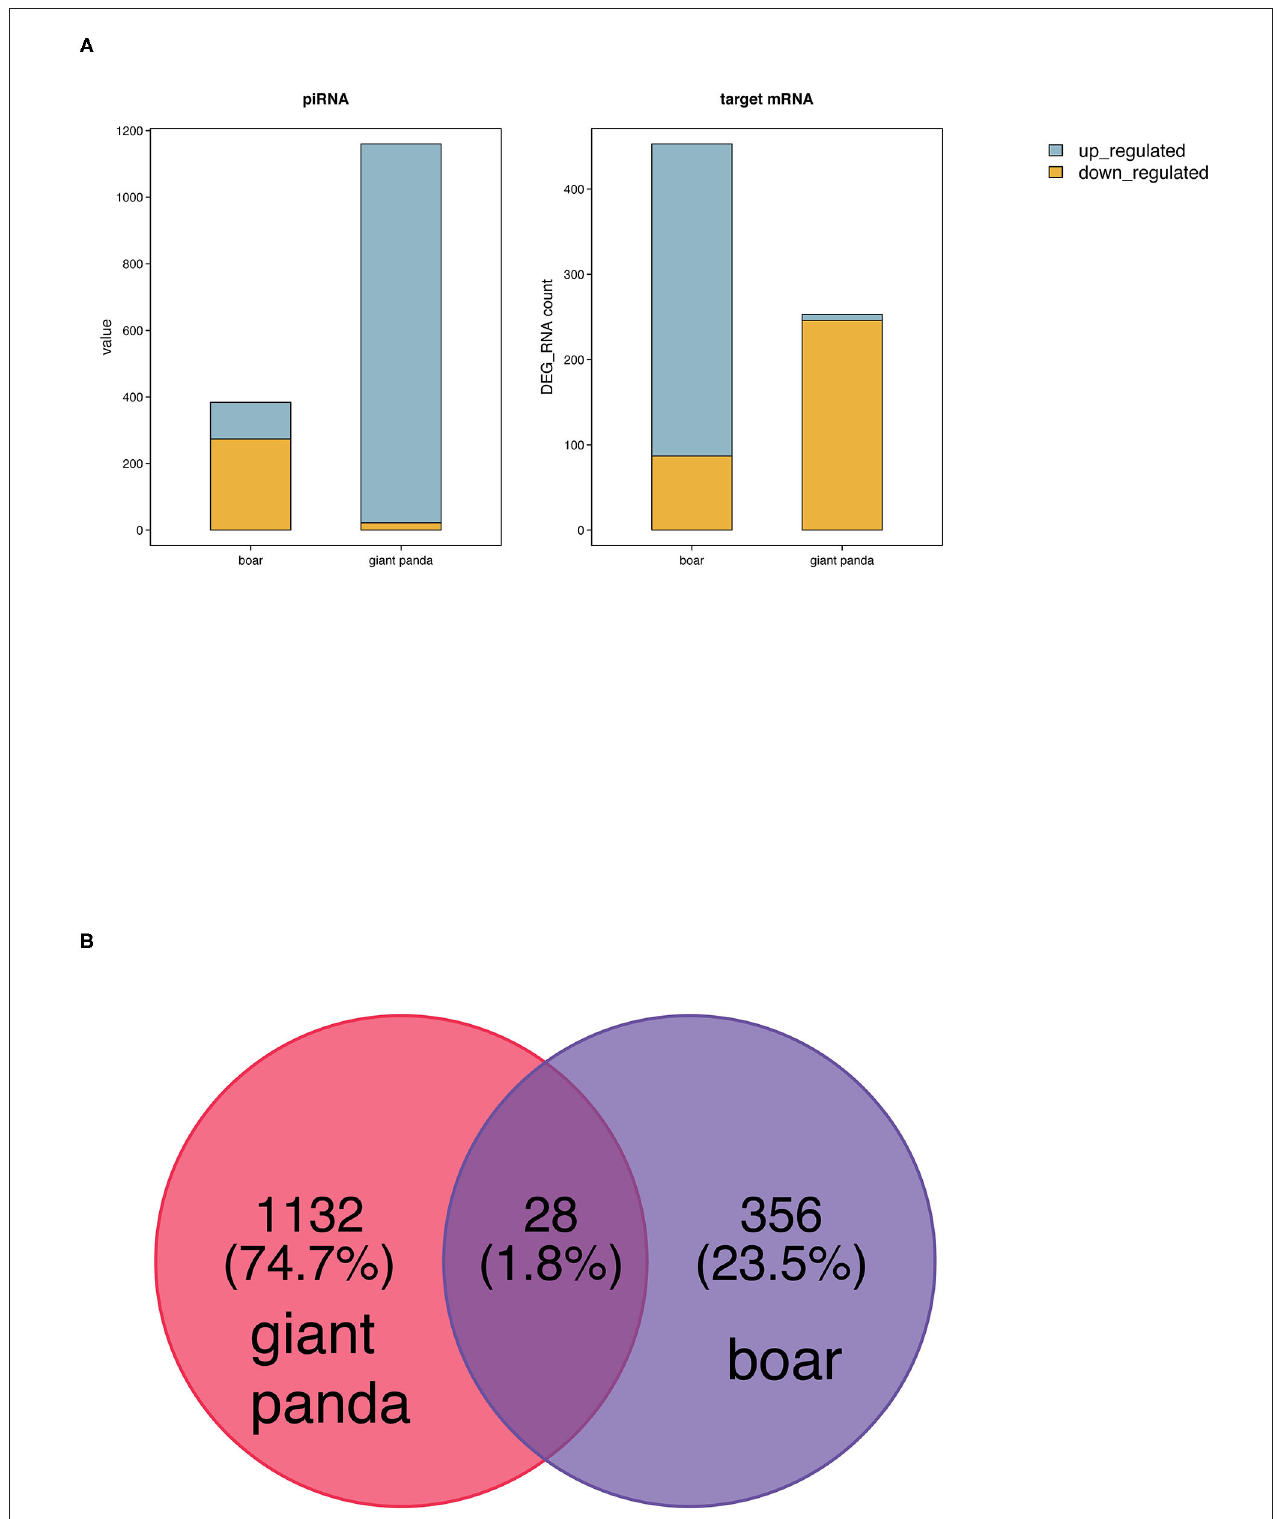
FIGURE 2 | Comparative analysis of differentially expressed PIWI-interacting RNAs (DE piRNAs) in fresh and frozen-thawed giant panda and boar sperm. (A) Comparison of DE piRNAs and target DE mRNAs. (B) Unique and common DE piRNAs.